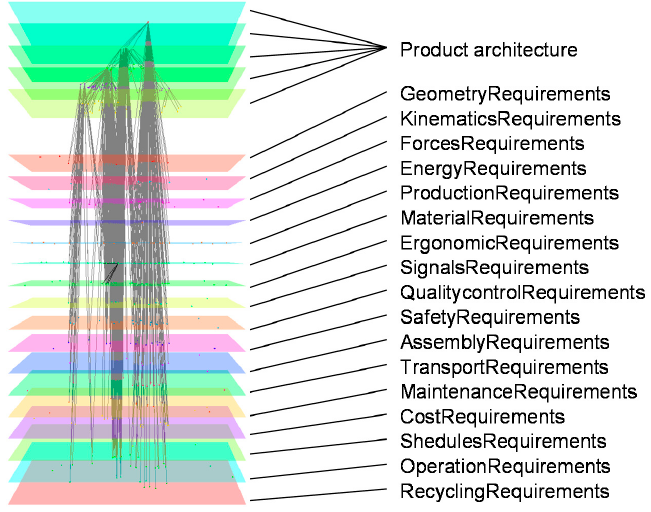
Figure 17. Example for a design graph of instances of the product architecture and requirements classified by the fourth taxonomy of Figure